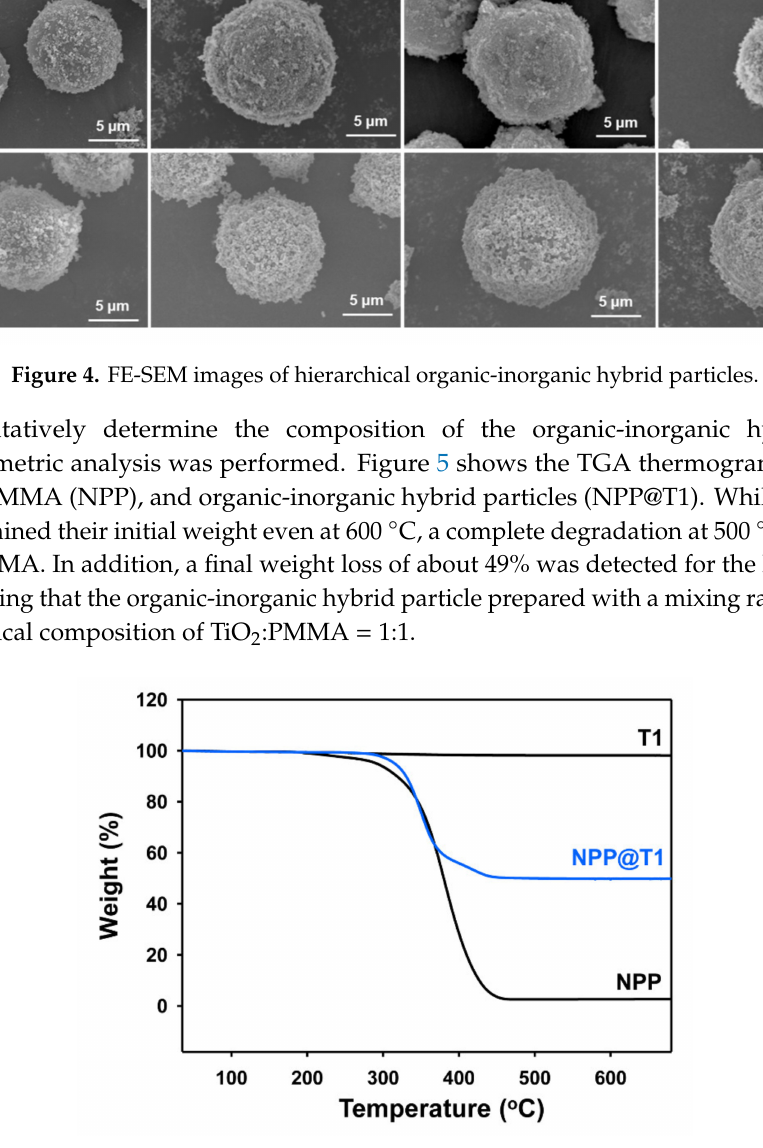
Figure 5. TGA thermograms of pure TiO 2 (T1), pristine PMMA (NPP), and hybrid particles